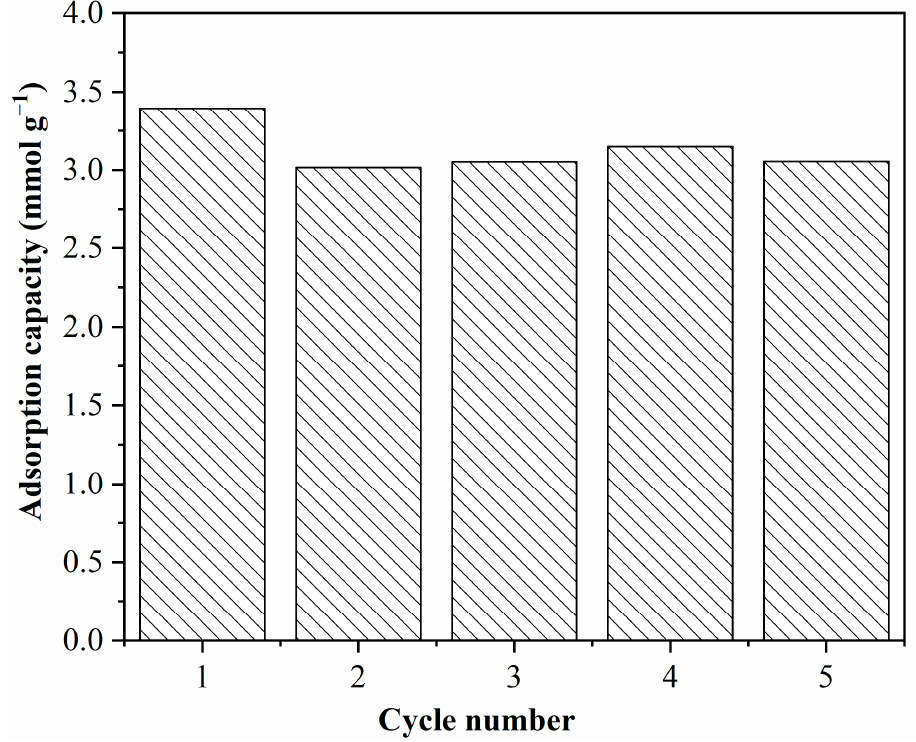
Figure 10. Recycle adsorption/desorption runs of AMMS-T (adsorption/desorption at 343/383 K).